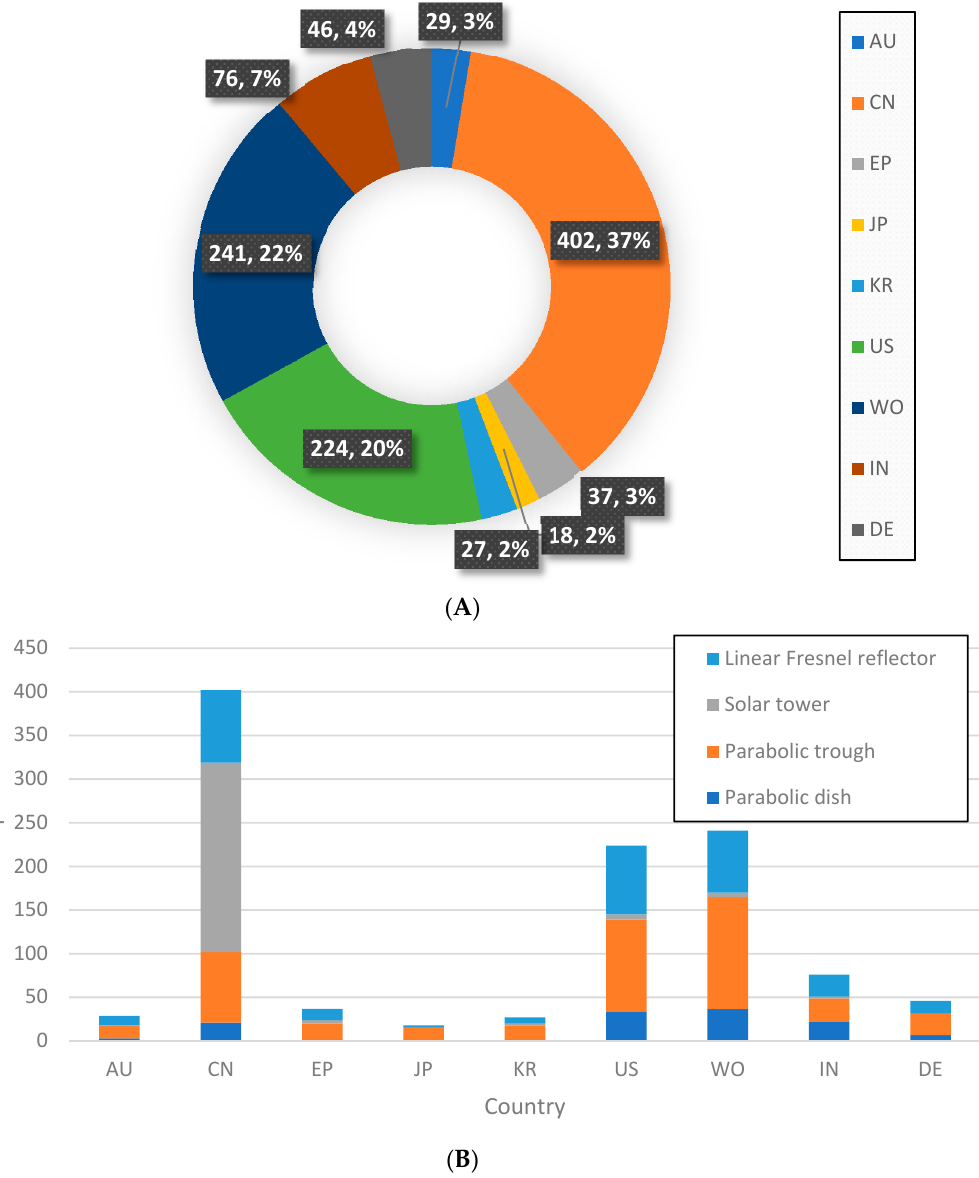
Figure 6. Distribution of origins of selected patents according to countries/organisations with Country codes: AU (Australia); CN (China); EP (European Union Office); JP (Japan); KR (Korea); US (the United States); WO (World Intellectual Property Organization, WIPO); IN (India); DE (Denmark) ( A ); Number of patents and solar energy technologies in ORC application for different countries/organizations ( B ).